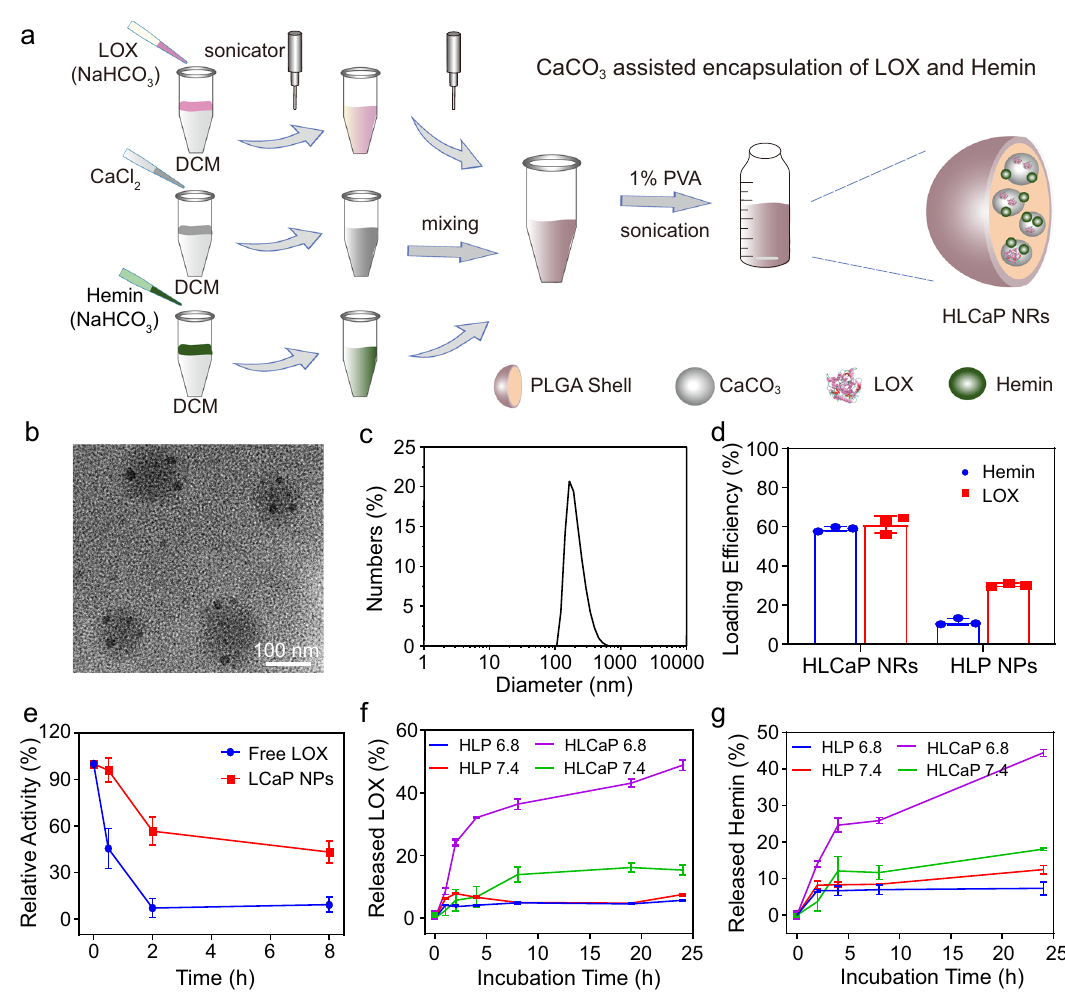
Fig. 2 Preparation and characterization of HLCaP NRs. a Schematic illustration of the preparation procedure of HLCaP NRs via the CaCO 3 -assisted double emulsion process. b A representative TEM image of HLCaP NRs from three independent experiments. c Hydrodynamic diameters of HLCaP NRs determined using a Malvern Zetasizer. d Loading ef fi ciencies of Hemin and LOX in HLCaP NRs and HLP NPs, the latter of which were prepared via the conventional double emulsion method without CaCO 3 . e The relative enzymatic activity changes of free LOX and LCaP NPs treated by protease K digestion assay. f , g Cumulative release of Hemin and LOX from HLCaP NRs and HLP NPs incubated at pH 7.4 and 6.8. Data in Fig. d – g were represented as mean ± standard error of mean (SEM), n = 3 biologically independent